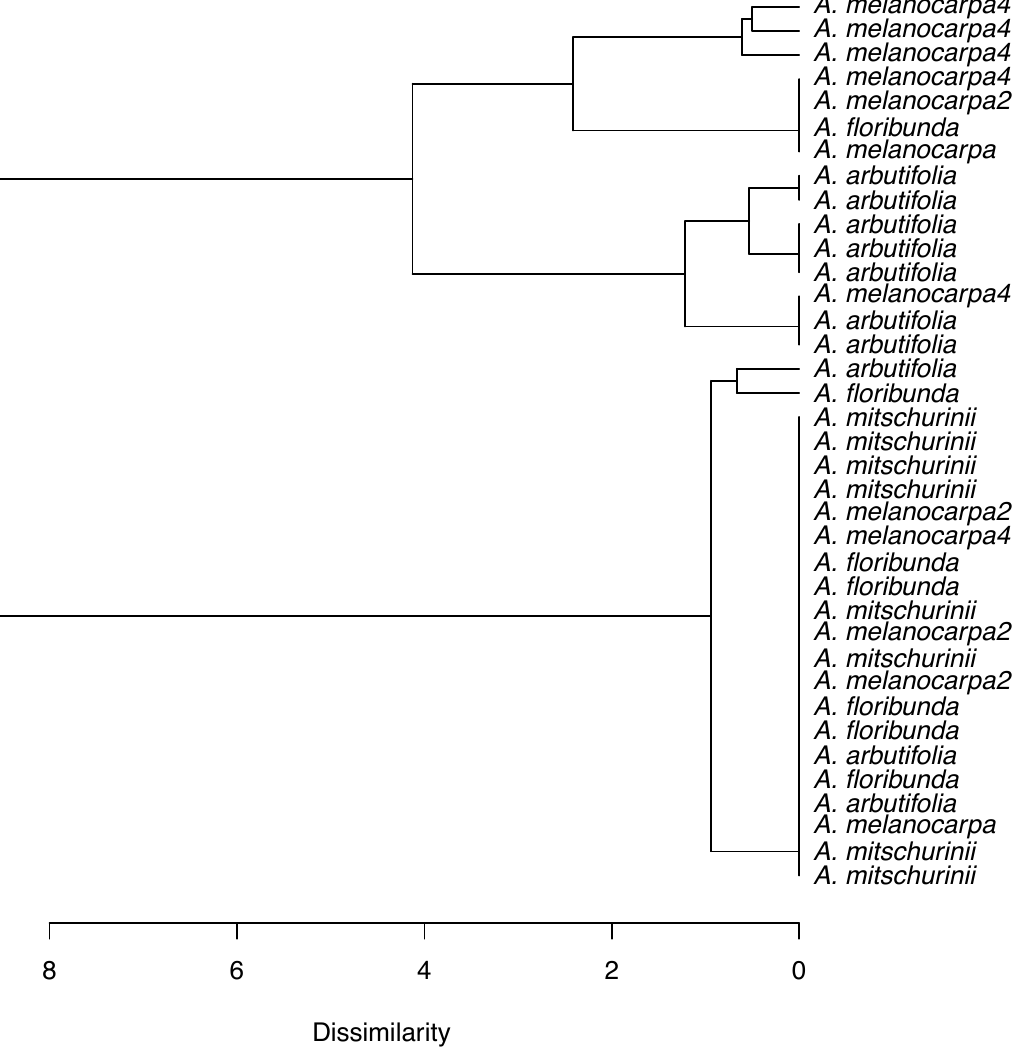
Fig. 3. Cluster analysis (binary distance, Ward clustering method) of the occurrence of eight basic rbc L and ITS2